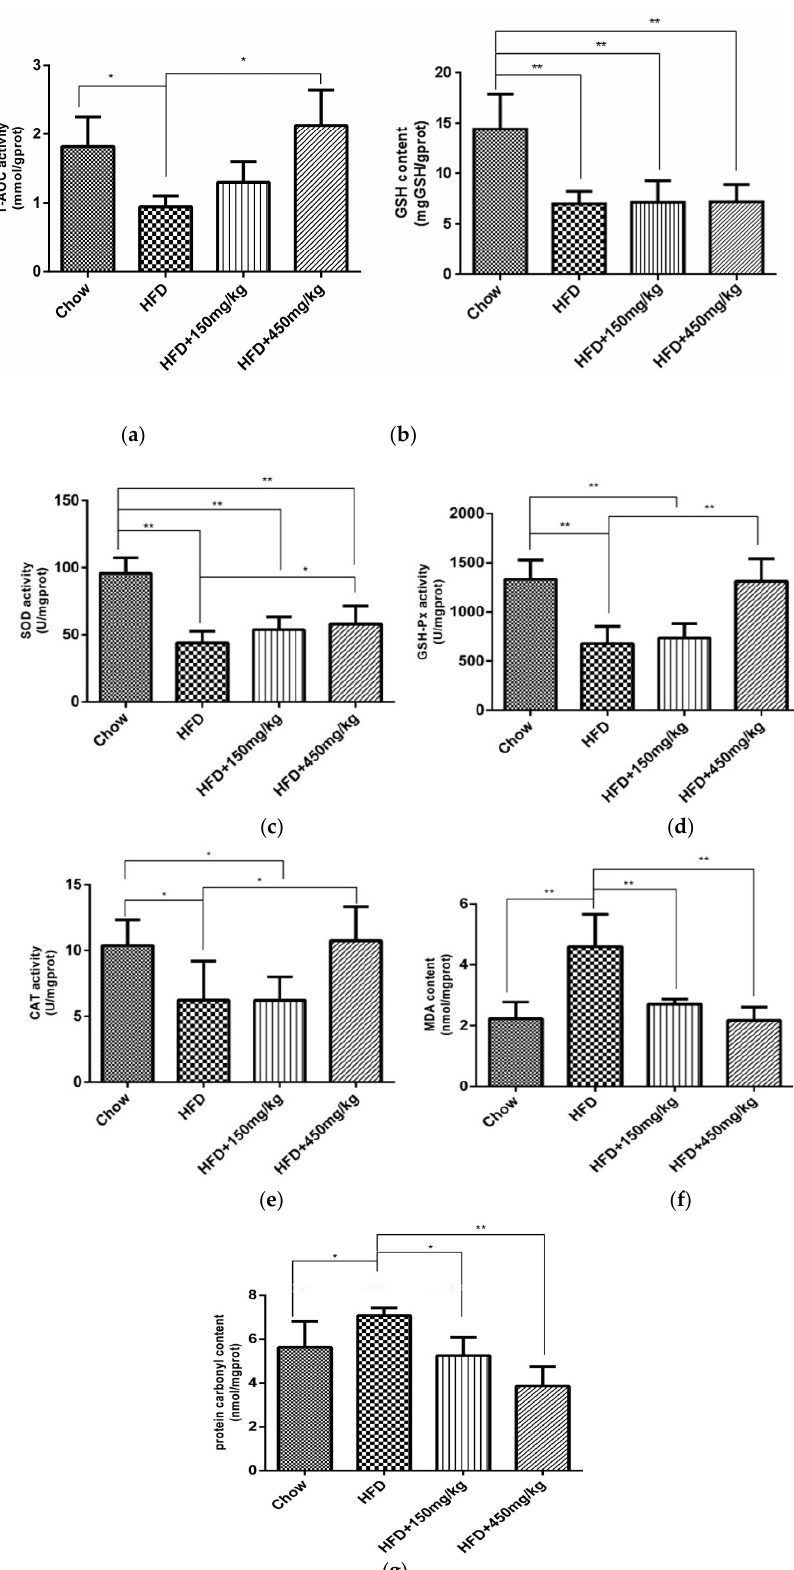
Figure 3. SIF improved oxidative stress and increased the activity of antioxidases. ( a ) The activity of T-AOC, ( b ) GSH, ( c ) SOD, ( d ) GSH-Px, ( e ) CAT; ( f ) The content of MDA, ( g ) Protein carbonyl. Error bars indicate SD. * p < 0.05, ** p < 0.005.